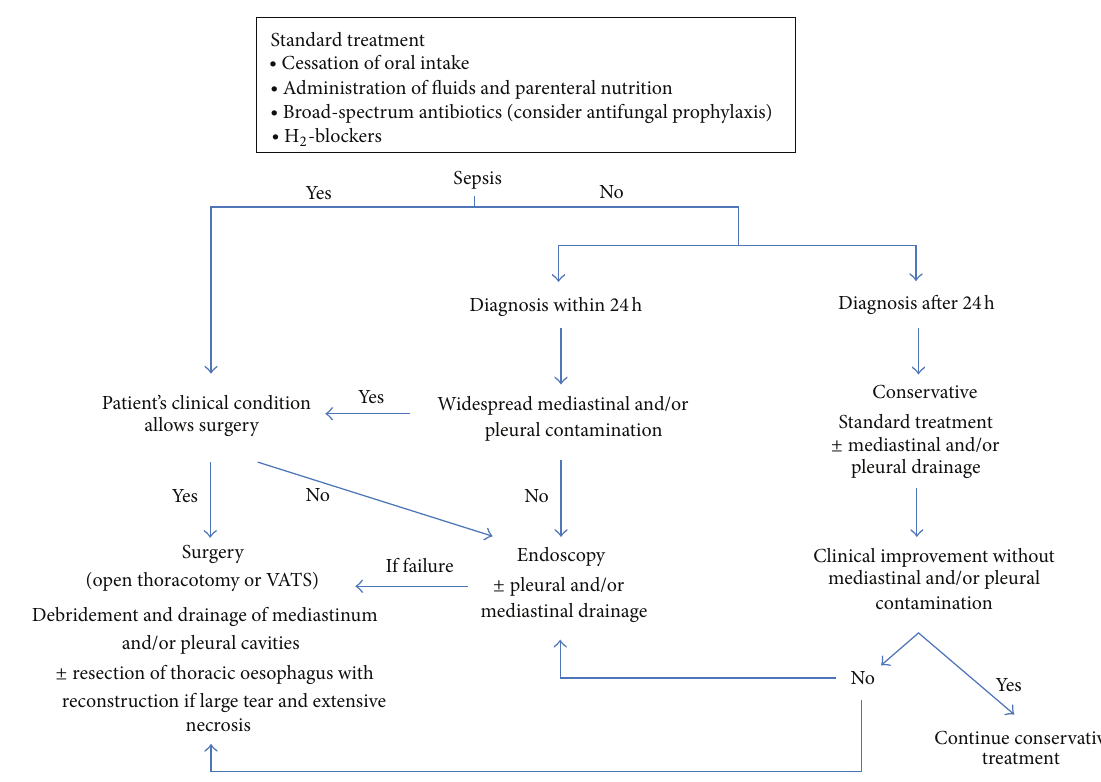
Figure 4: Boerhaave’s syndrome treatment